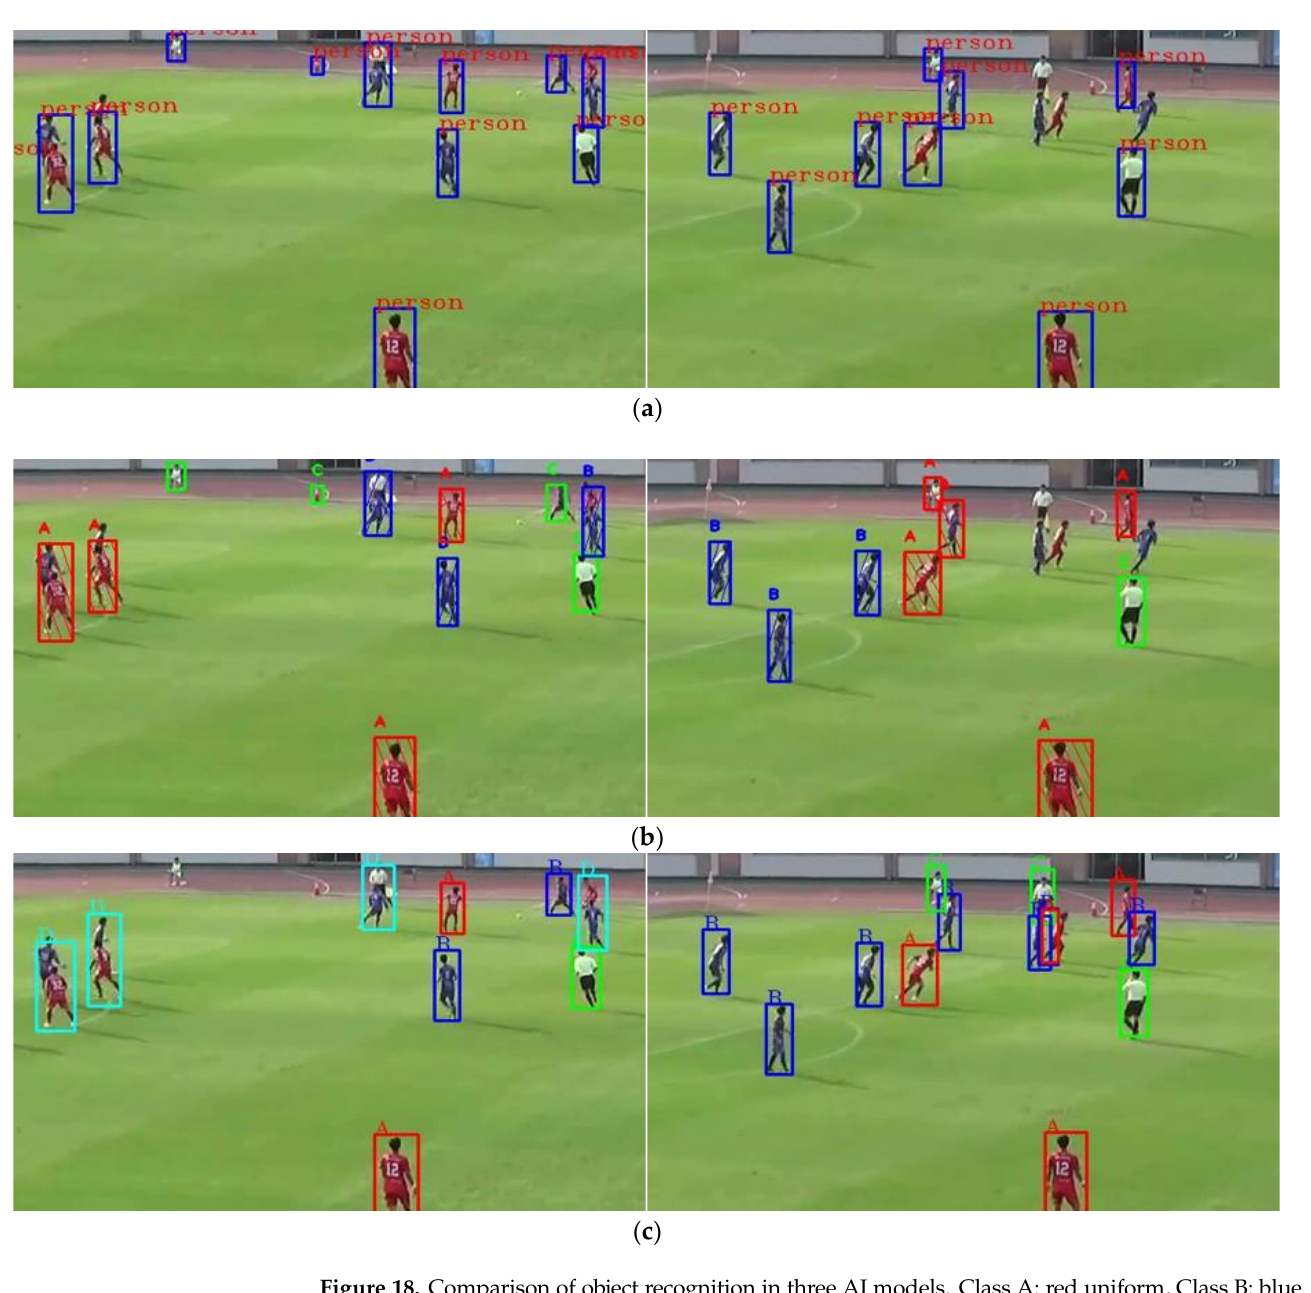
Figure 18. Comparison of object recognition in three AI models. Class A: red uniform, Class B: blue uniform, Class C: white uniform, Class D: overlapped objects; ( a ) Objects recognition in Yolov3-416 model; ( b ) Objects recognition in Yolov3-HSV model; ( c ) Objects recognition in Yolov3-Augment